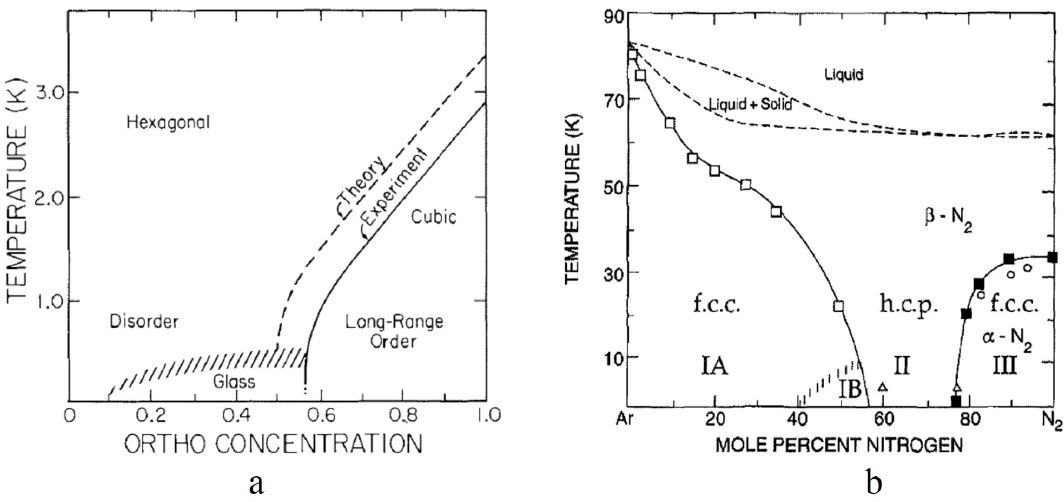
Figure 3. Phase diagrams for orientational and quadrupolar ordering in solid ortho-para H 2 mixtures[21,25,26] and solid N 2 -Ar mixtures[28,37]. ( a ) Phase diagram of solid ortho-para H 2